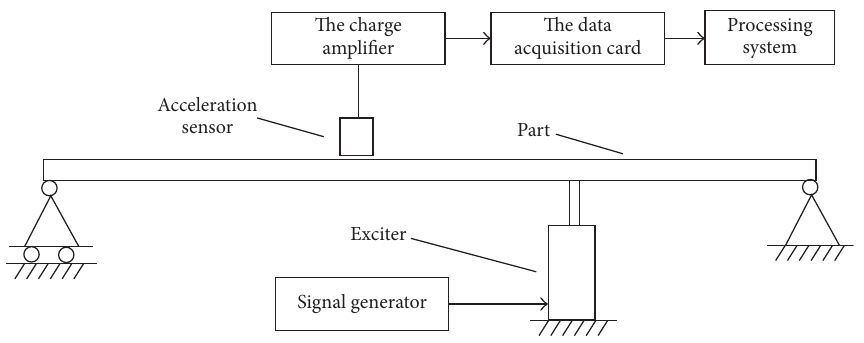
Figure 1: The diagram of test